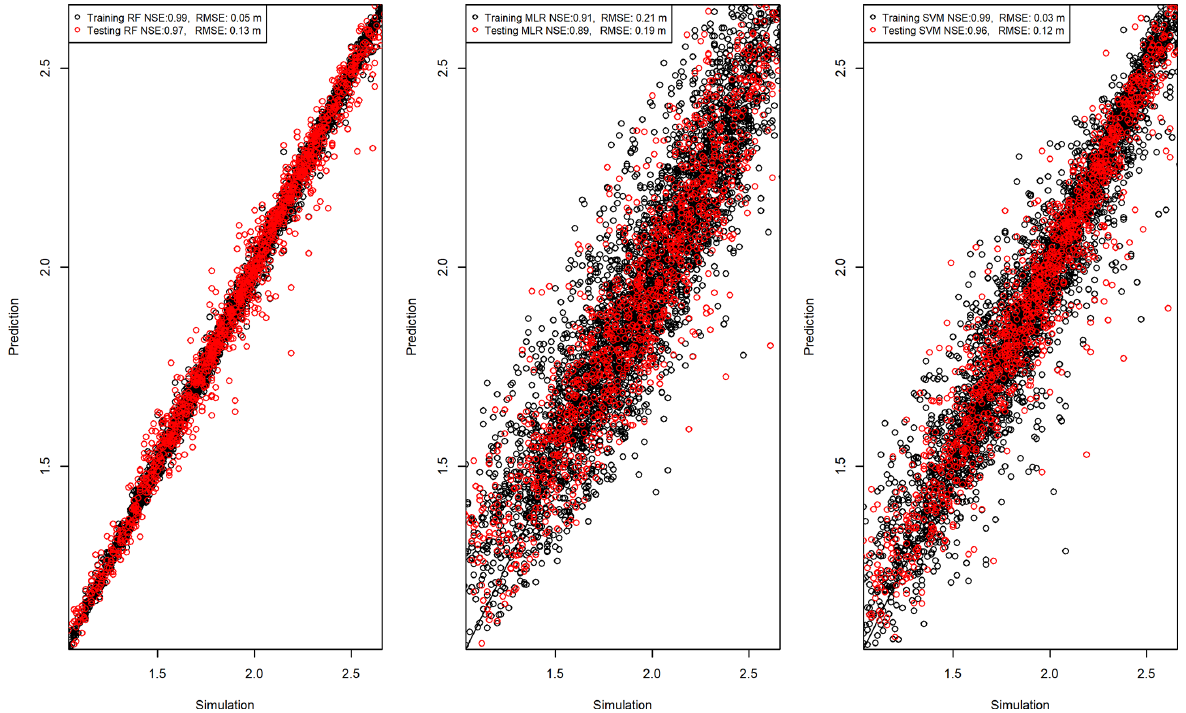
Figure 10. Comparison of predicted and simulated hourly water levels of the training data.